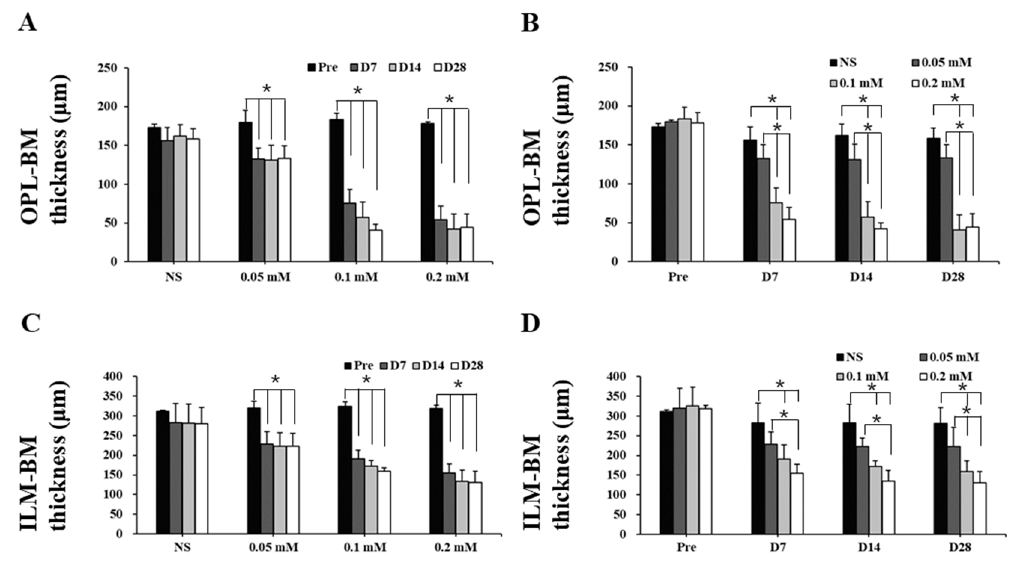
Figure 4. Retinal thickness of monkeys decreased after SNP treatment in both a dose- and time-dependent manner. ( A , C ) Compared with pretreatment at each time point, the thickness of the outer retina ( A ) and whole retina ( C ) in the lesion area was not significantly reduced in the NS control group but was significantly reduced in all three doses of the SNP groups. ( B , D ) Compared to the NS group, the thickness of the outer retina ( B ) and whole retina ( D ) in the lesion area was not significantly reduced in the 0.05 mM SNP group but was significantly reduced in both the 0.1 and 0.2 mM SNP groups 7 to 28 days after treatment. *: p < 0.05.